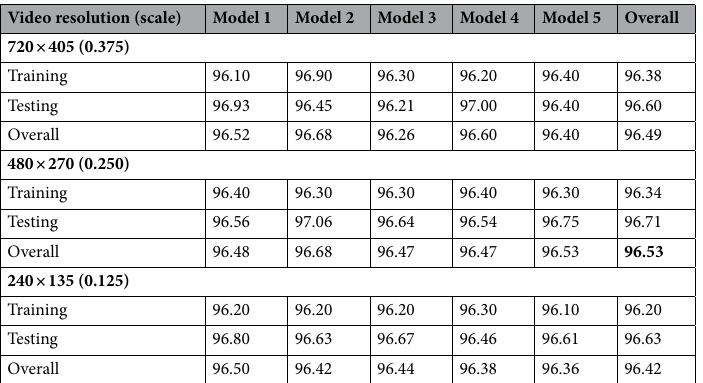
Table 5. Classification accuracies for dynamic signs at 200 bags. Significant values are in bold.